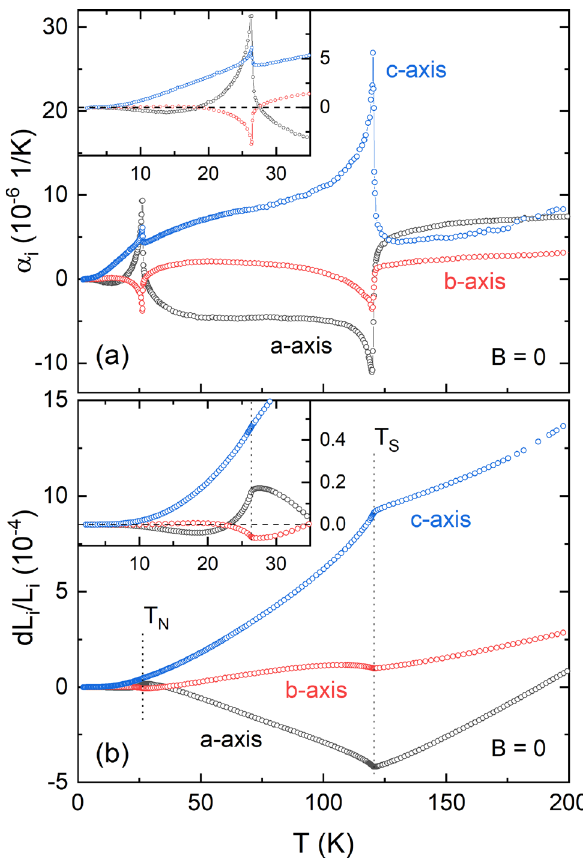
Figure 1. Zero-field thermal expansion: ( a ) Thermal expansion coefficients α i and ( b ) relative length changes dL i / L i in zero-field for the crystallographic a , b , and c axis of CBSCl. Insets show a magnification of the low temperature regime around T N with zero y-values indicated by horizontal dashed lines. Vertical dotted lines in ( b ) mark T N and T S